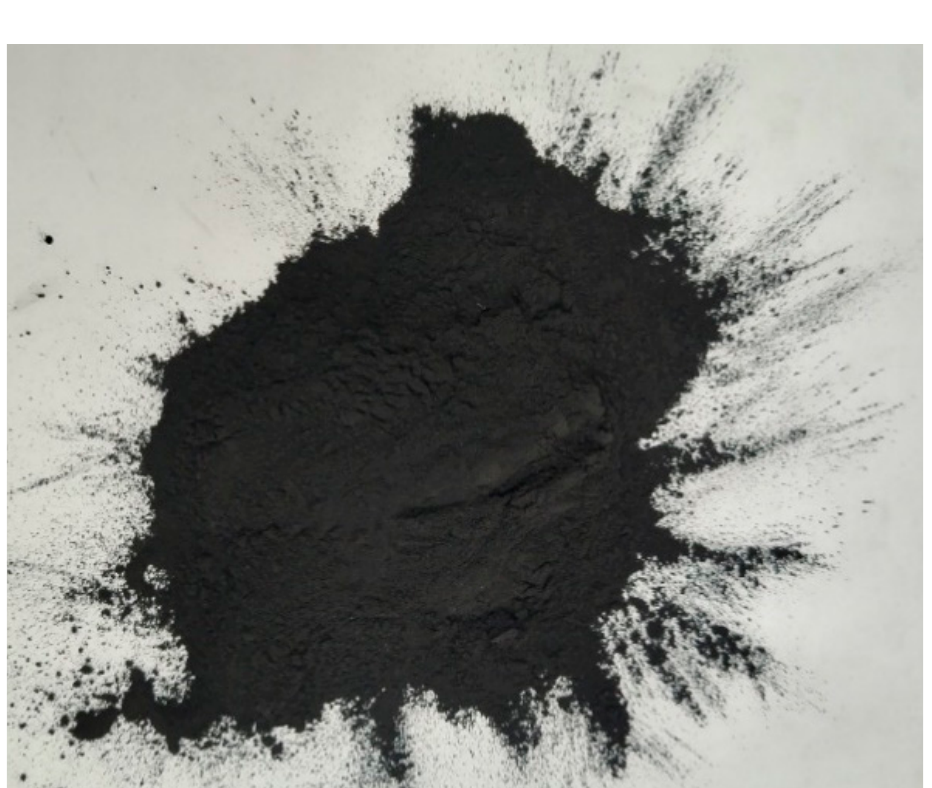
Figure 1. Activated carbon in powdered form. Table 1. Chemical properties of binder materials [17].